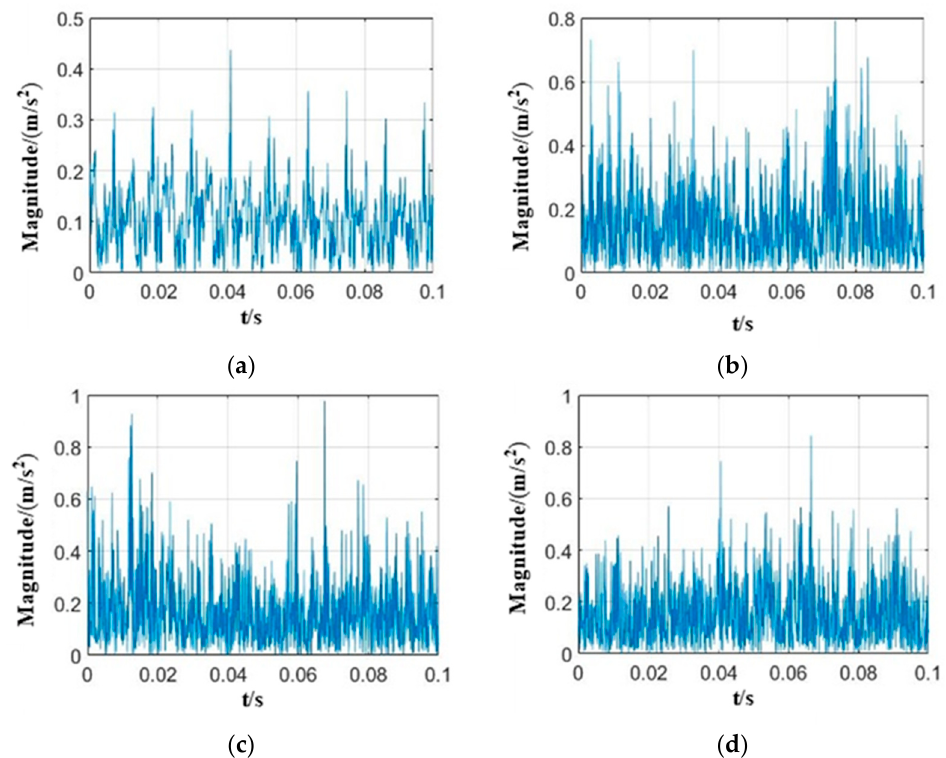
Figure 4. Time domain waveform in X-direction of the pump inlet pipe. ( a ) normal operation. ( b ) incipient cavitation. ( c ) cavitation. ( d ) severe cavitation.